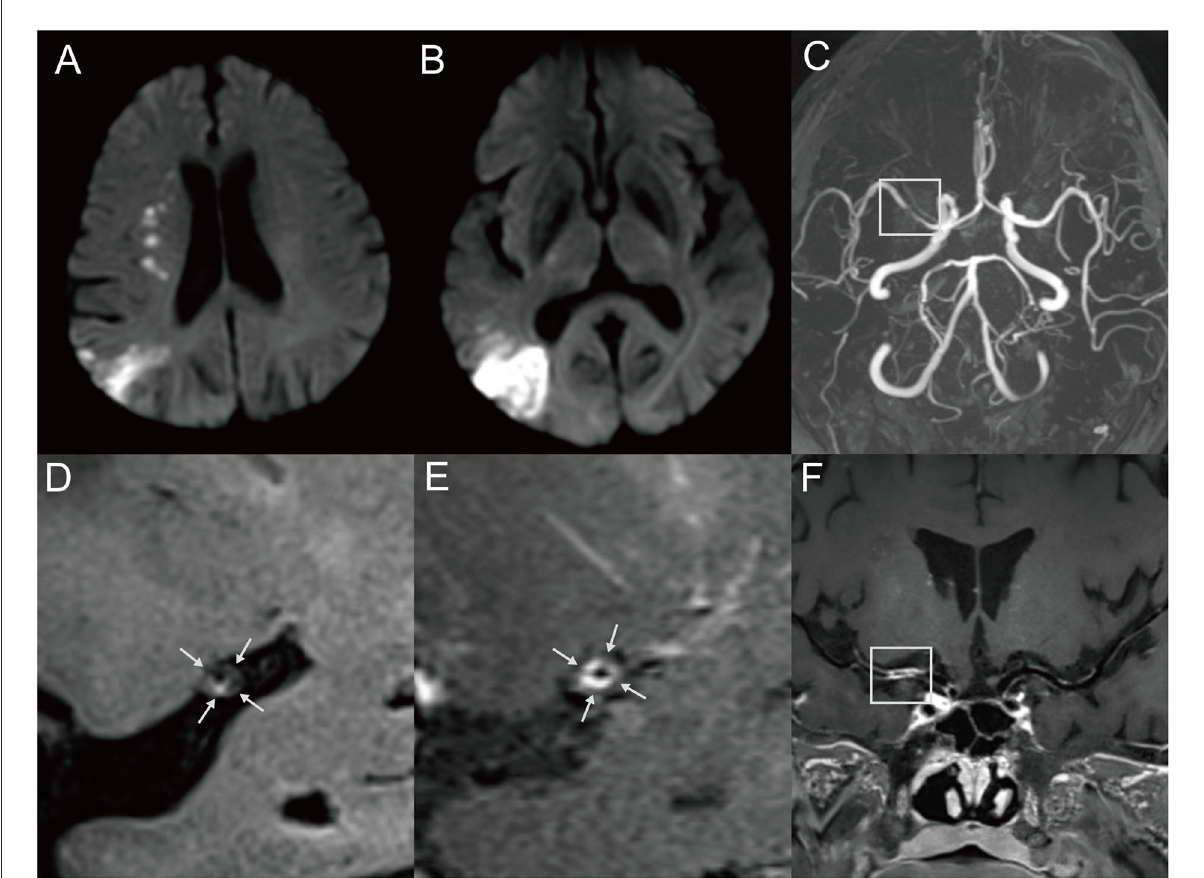
FIGURE2 Representative MR images of a 60-year-old male patient with multiple MCA infarctions. (A,B) DWI showed chain-like internal border-zone infarctions and wedge-shaped or spotty cortical infarctions in the right MCA territory. The patient with a cigarette smoking history presented with left-side weakness and mouth askew for 4 days. (C) 3D-TOF-MRA demonstrated severe stenosis (box) of the right MCA. (D) Pre-contrast HRMRI showed a diffuse distributive plaque with a spotted high signal (intraplaque hemorrhage) at the inferior wall of MCA (arrow). (E) Postcontrast HRMRI demonstrated obvious plaque enhancement (arrow). (F) The postcontrast T1-weighted image by curved planar reformation showed a diffuse plaque located at the proximal M1 segment of the right MCA